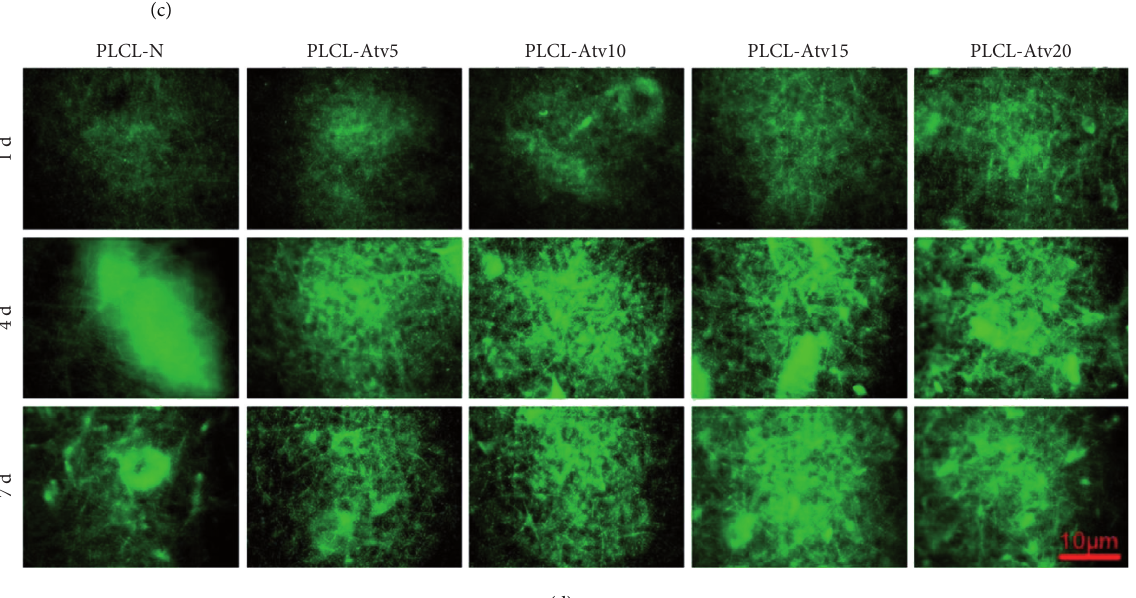
Figure 3: (a) HUVEC migration in different nanofiber film environments after 6, 12, and 24 hours and (b) micrographs stained by crystal violet. (c) The NO release of HUVECs on different nanofiber films and (d) micrographs of fluorophore probe DAF-FMDA. ∗ Significant difference of p < 0 . 05; reproduced with permission from